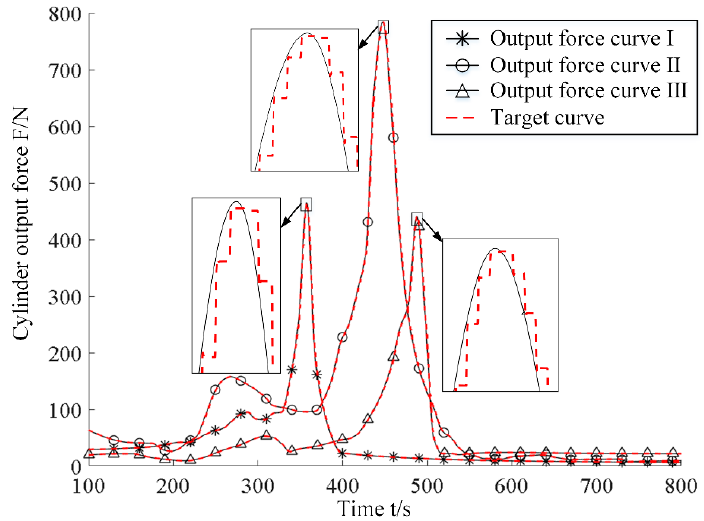
Figure 12. Co-simulation